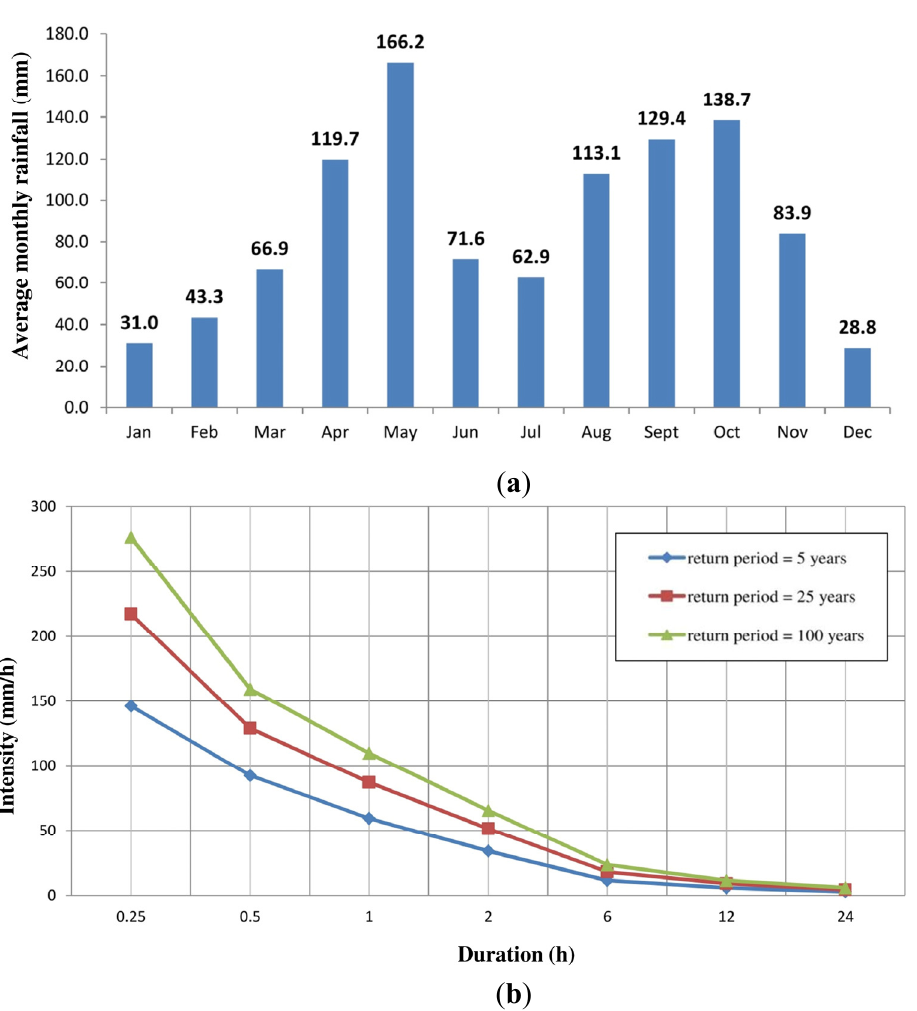
Figure 7. ( a ) Average monthly rainfall at Damien based on 68 years of record between 1927 and 2002 and ( b ) IDF-curves for Damien station